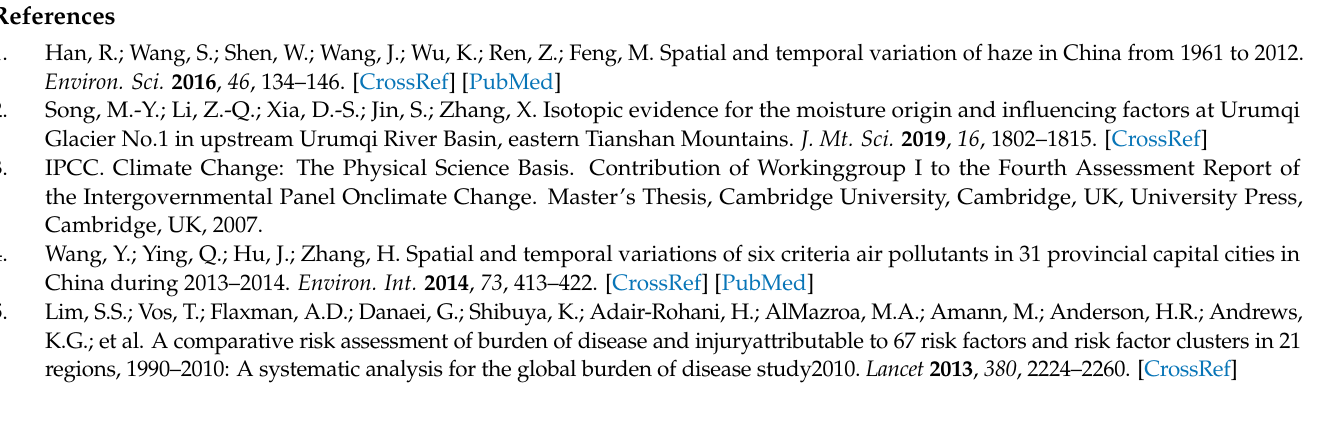
e CO.f PM 10 ; Figure S4: Polar plots of SO 2 , NO 2 , CO, O 3 , PM 2.5 and PM 10 concentrations in the Urumqi. a SO 2 . b O 3 . c NO 2 . d PM 2.5 . e CO. f PM 10